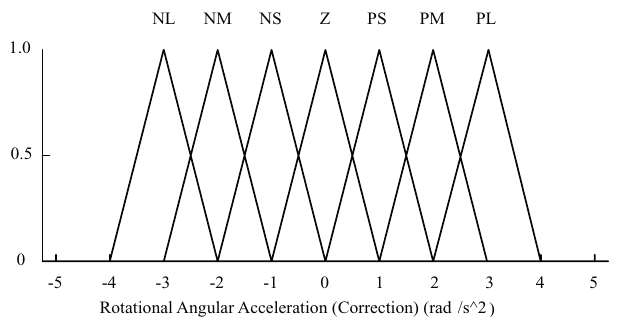
Fig. 15. Fuzzification of ˙ θ ( t ) .